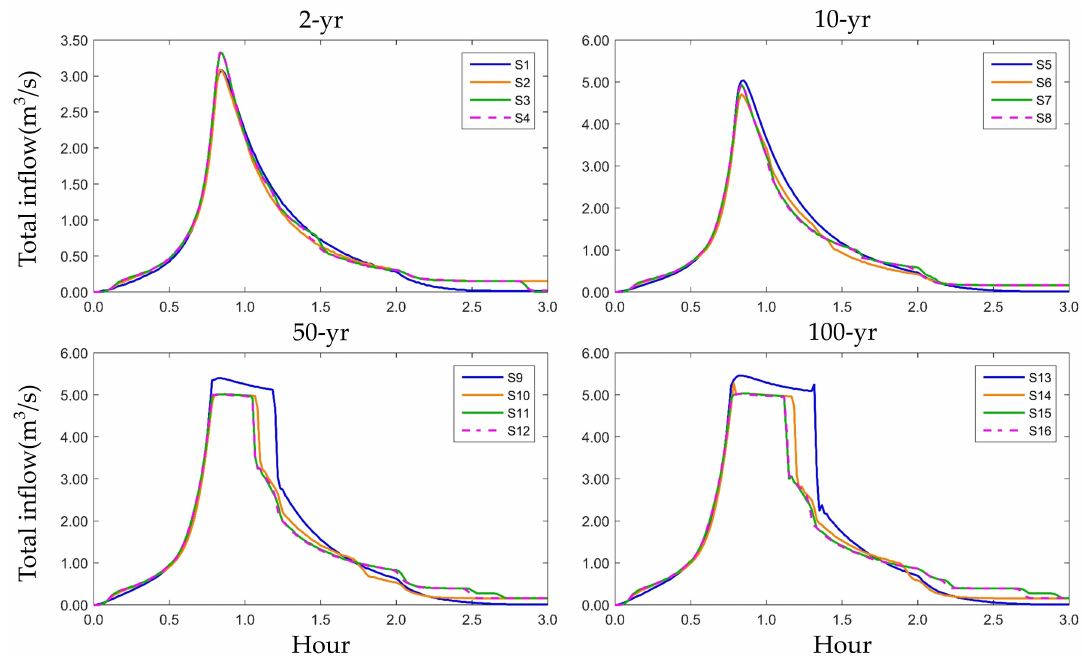
Figure 11. Total inflow hydrographs of outfall 1Y108 in the northern district for the 16 scenarios.